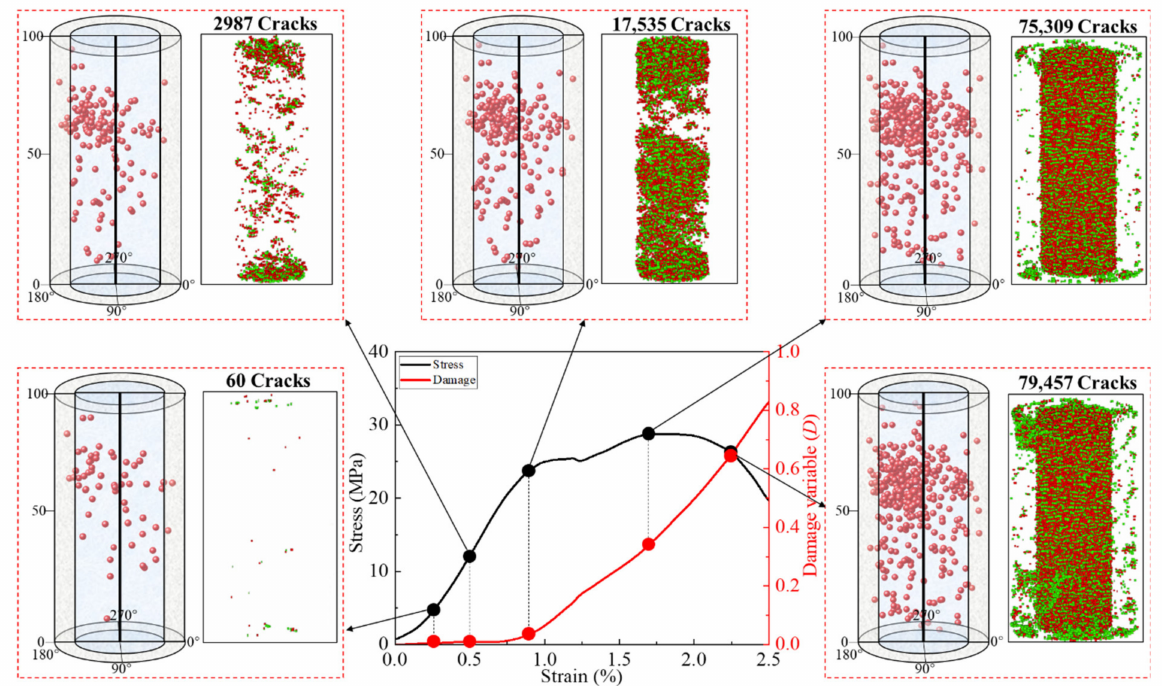
Figure 18. The composite diagram of the stress, damage, AE events, and cracks of the